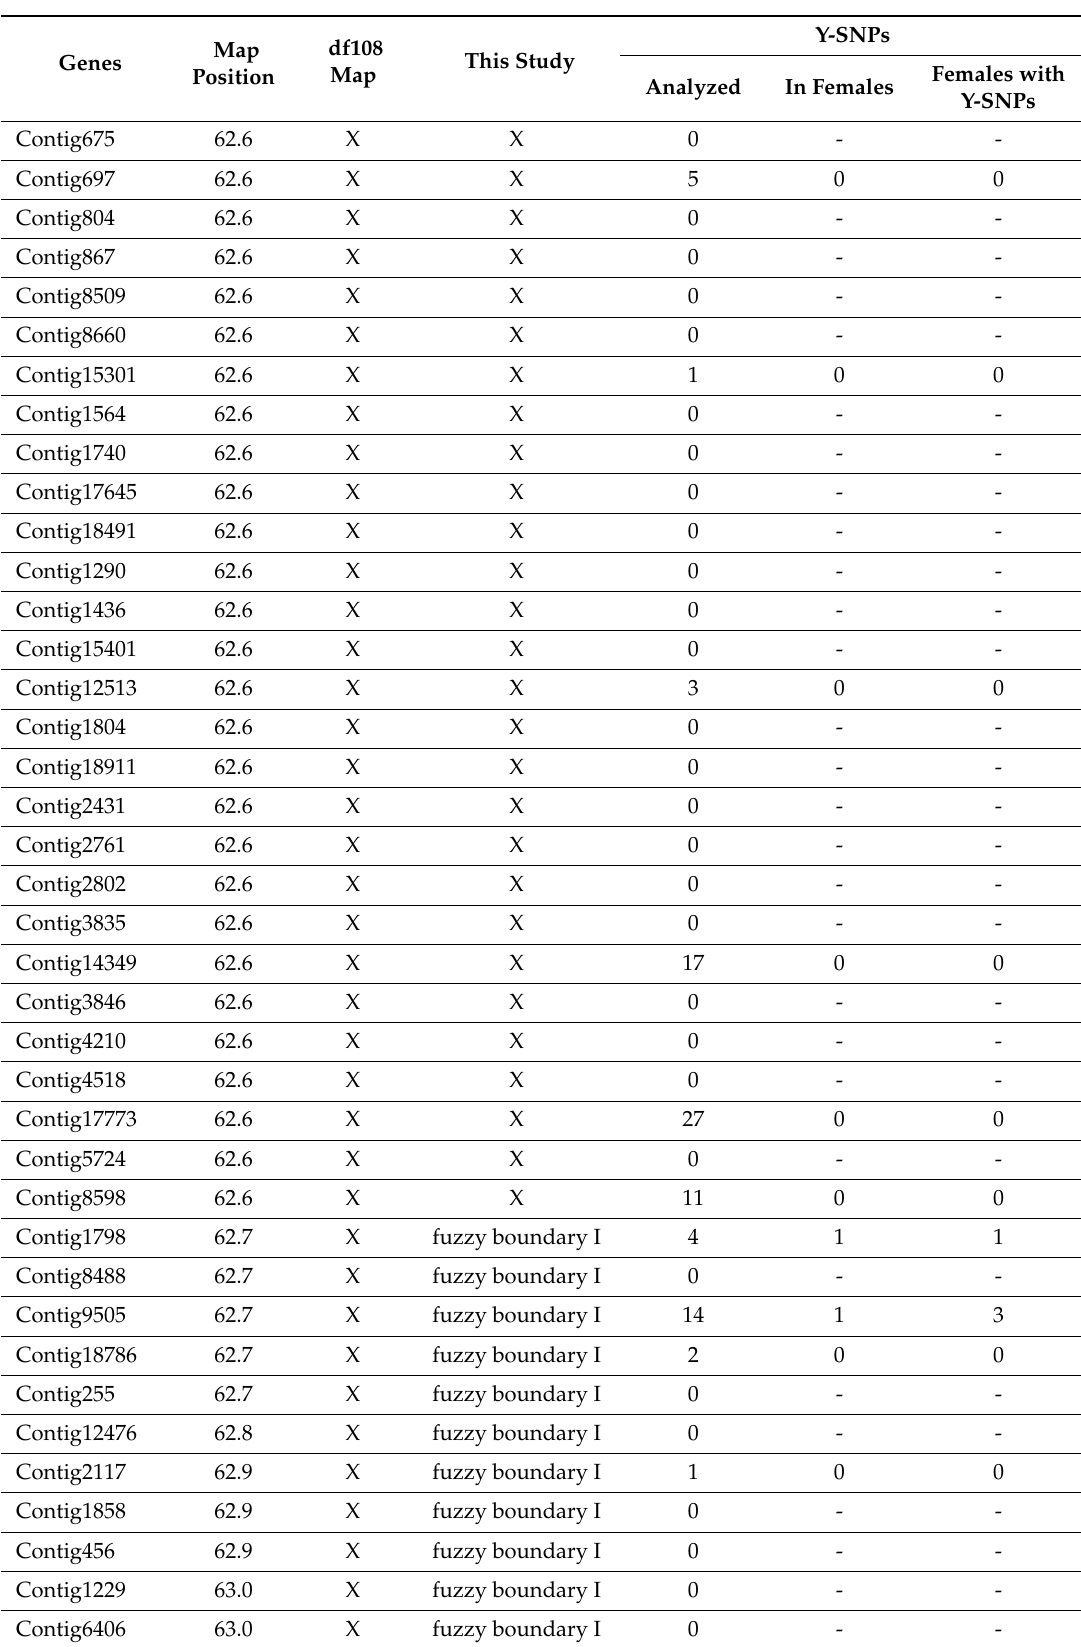
Table 3. The presence of Y-SNPs in wild females (genotypes are listed in Table S1).